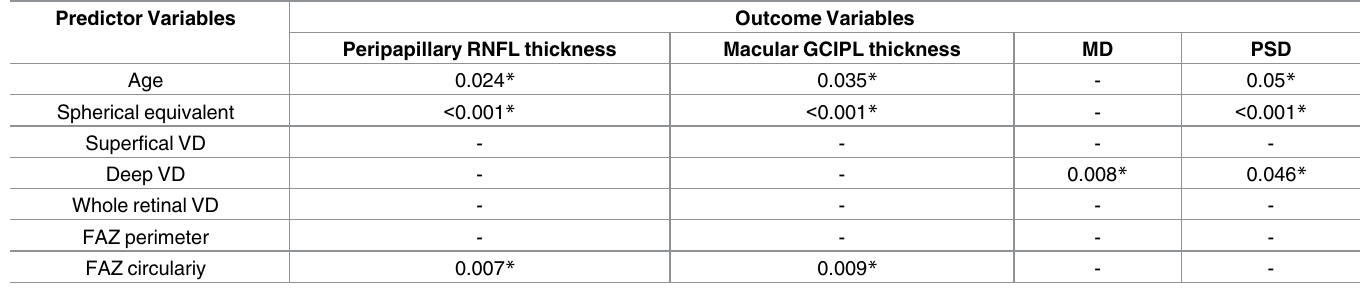
Table 3. Significance of independent variables in predicting outcome of glaucoma: Multivariate